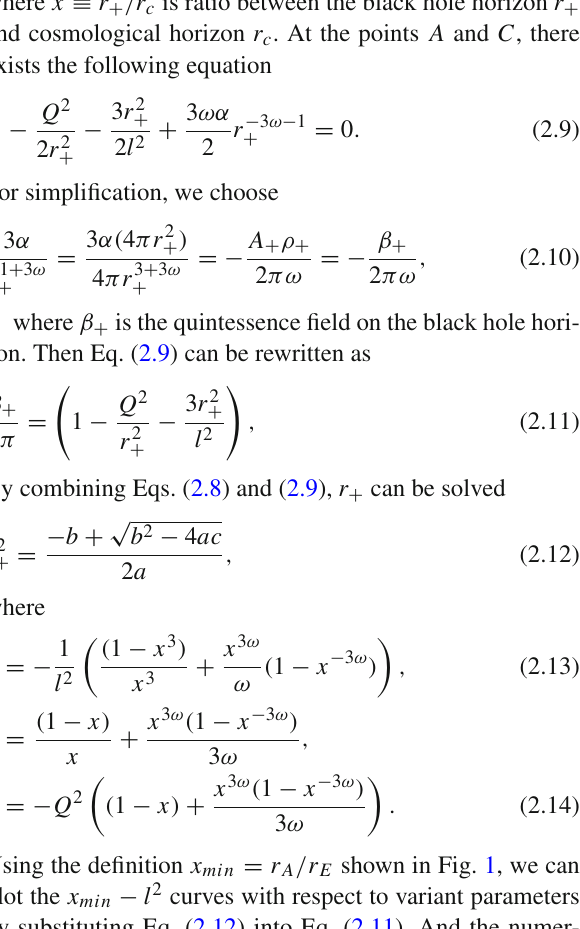
Table 2 Minimum values of the ratio between two horizon x 2 for given other